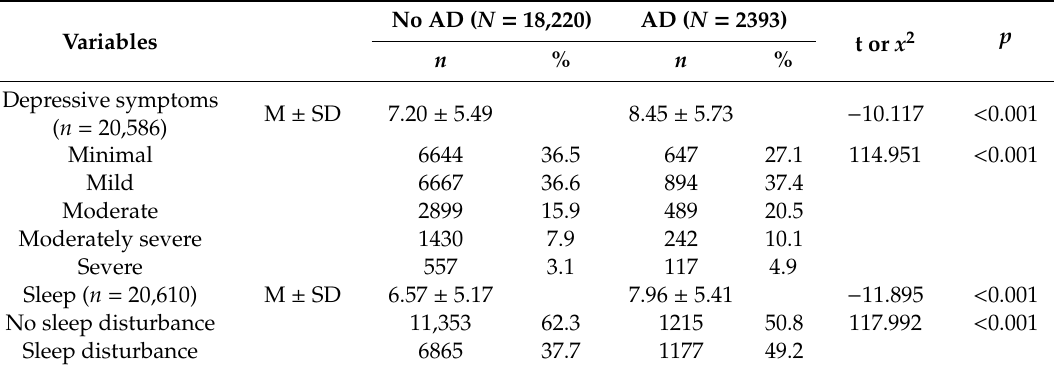
Table 2. Di ff erences in depressive symptoms and sleep among subjects with and without atopic dermatitis ( N =